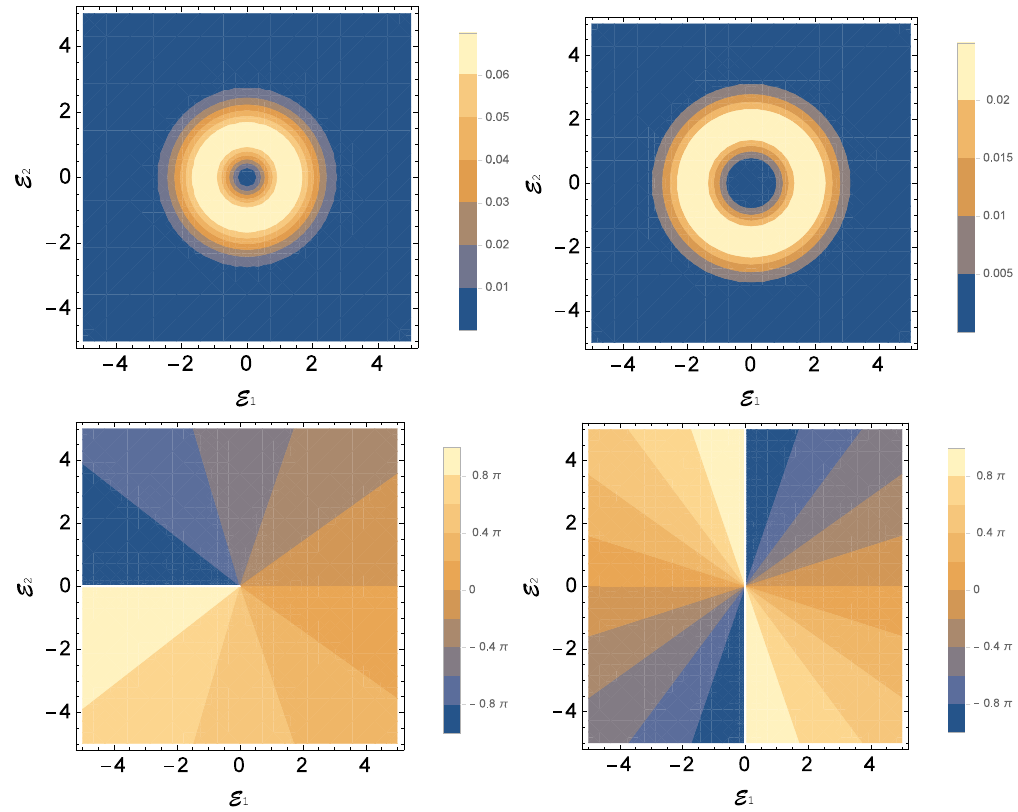
Figure 2. Plots of probability ( upper ) and phase ( lower ) densities of quantum vortices of order 1 ( left ) and 2 ( right ) with a squeezing factor s = 0.25.